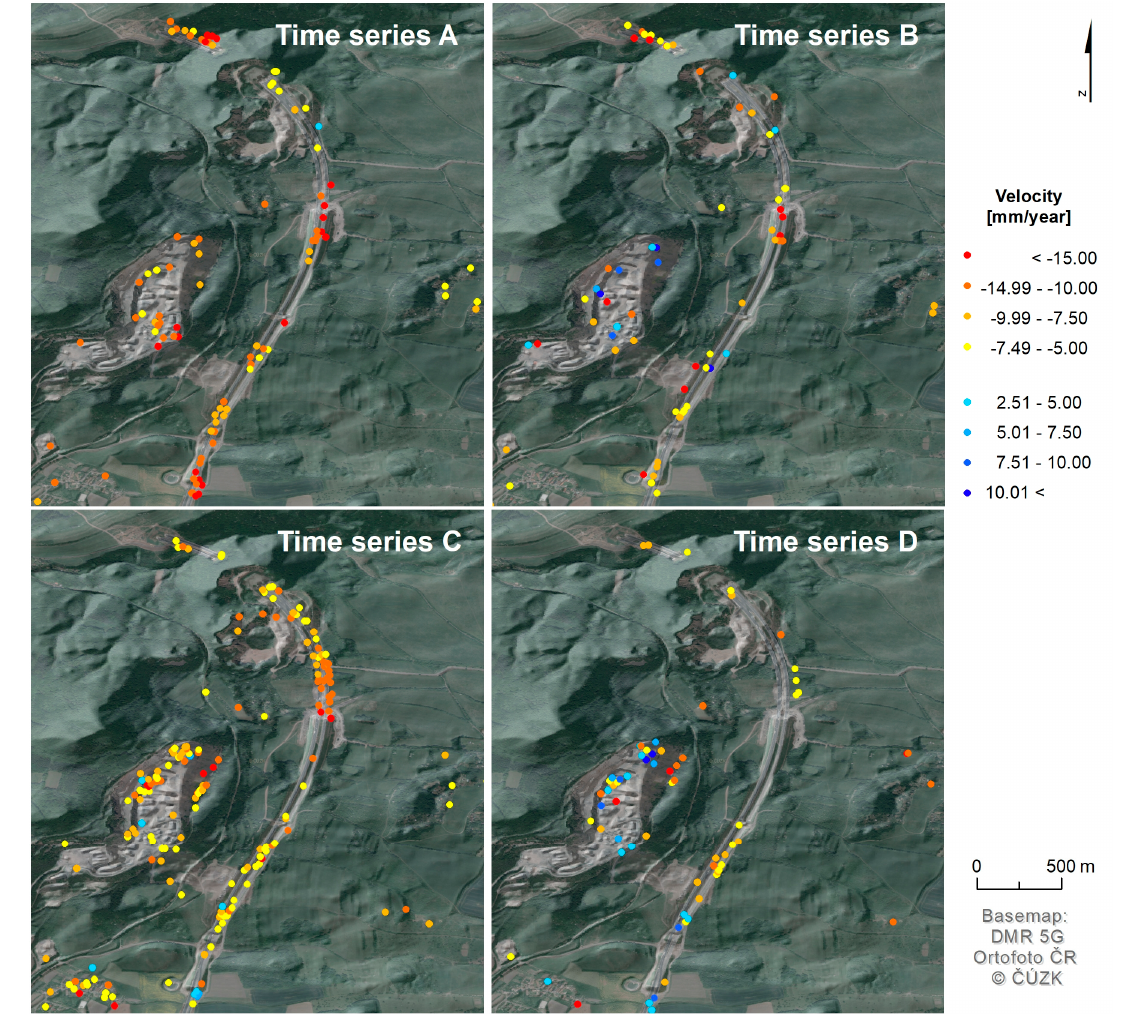
Figure 10. Displacement velocity (in LOS) of all processed time series ( A – D Figure 11: